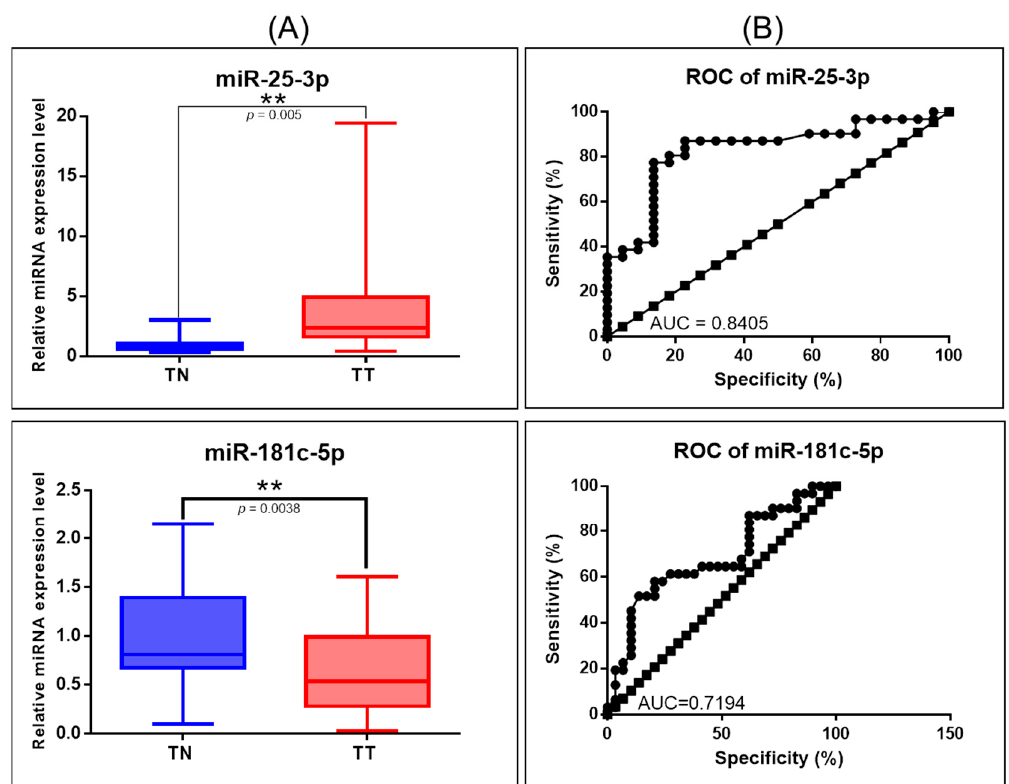
Figure 6. miRNA targeting key Hippo signaling genes in OC. ( A ) Scatter plots demonstrating the upregulation of miR-25-3p and downregulation of miR-181c-5p in tumor tissues versus normal adjacent tissues. We used for normalization of the miRNA expression data, U6 and RNU48 as the internal controls (** p ≤ 0.01); ( B ) ROC curve for miR-25-3p and miR-181c-5p.